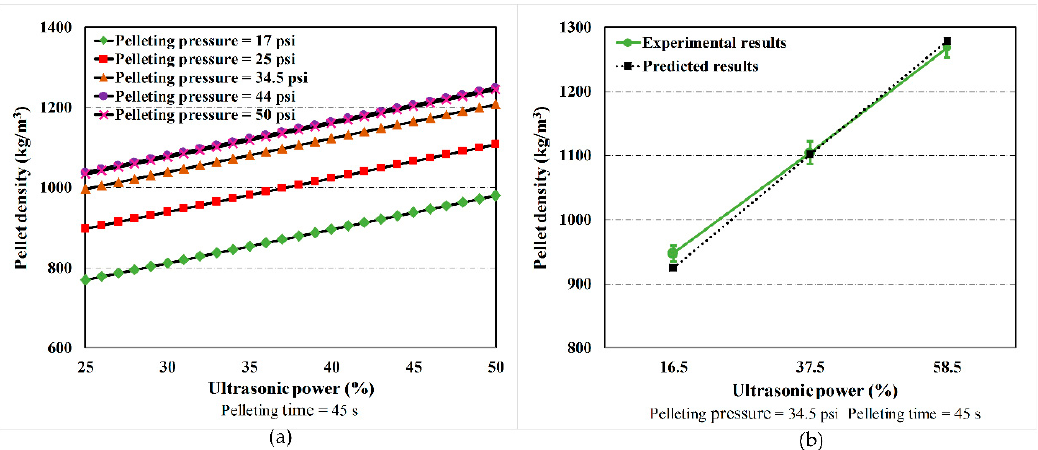
Figure 3. The effects of ultrasonic power on the pellet density. ( a ) The predicted pellet density in relation to the ultrasonic power at various levels of pelleting pressure (ranging from 17 psi to 50 psi) when the pelleting time was set to 45 s and the ultrasonic power increased from 25% to 50%. ( b ) For pellet density, the comparison between the model results and experimental results at various levels of ultrasonic power (mean value ±